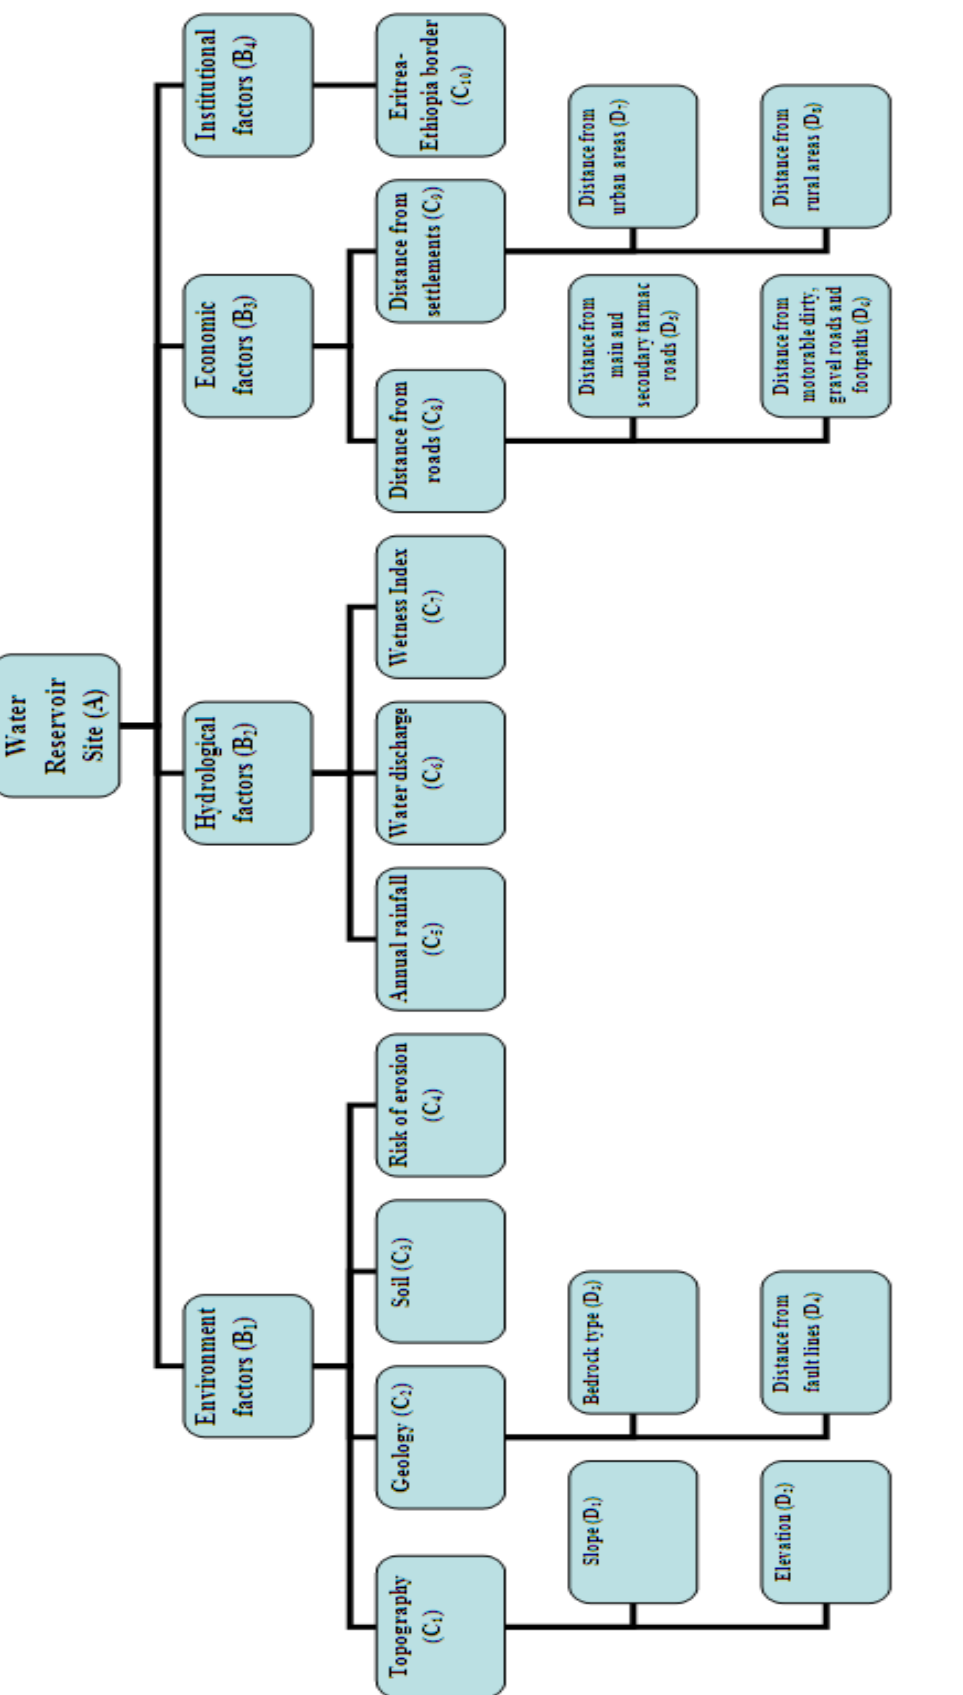
Figure 6. Hierarchy model for water reservoir